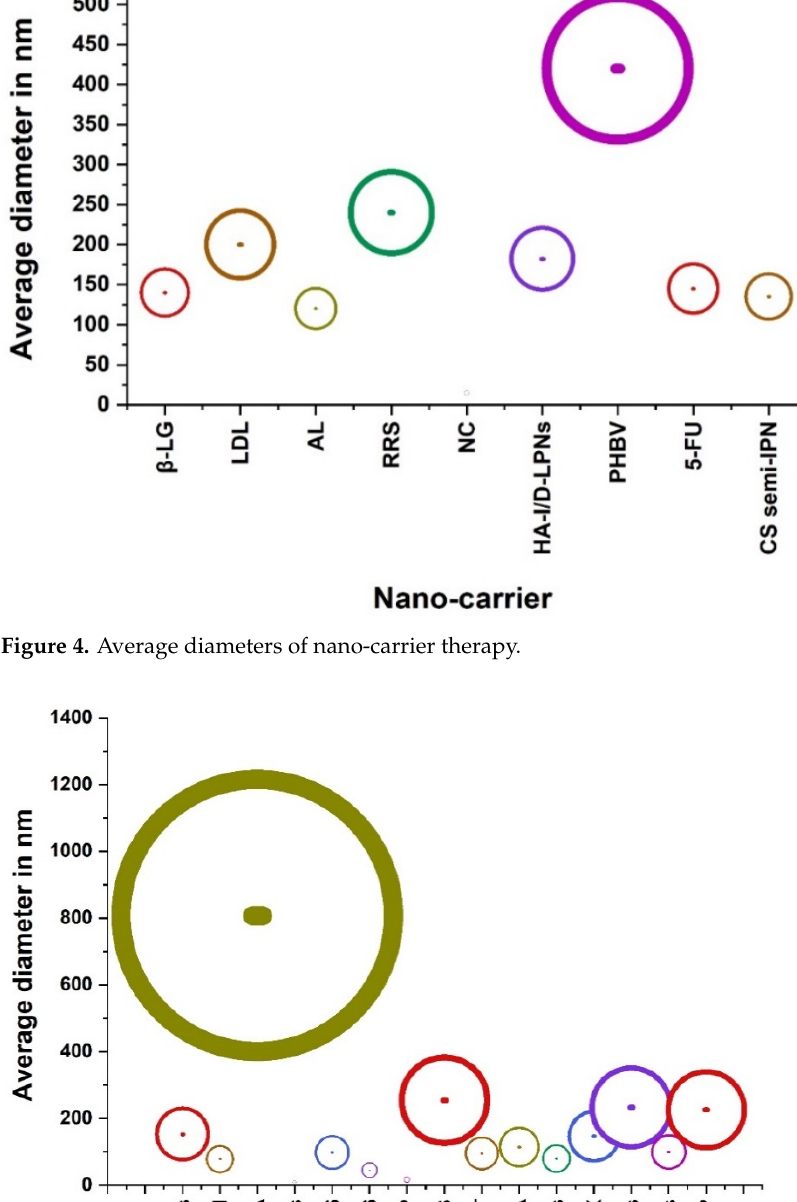
Figure 6. Average diameters of anti-cancer therapy. Solutions and Future Perspectives For example, nanoparticles (NPs) are increasingly being employed to deliver medi- cations in the treatment of colorectal cancer. These substances have been demonstrated to help treat this condition. Several hurdles must be overcome before a good cancer treat- ment system can be developed. A perfect pharmaceutical system can overcome biological barriers, detect damaged tissues, and provide an instantaneous amount of a therapeutic chemical or combination. A very successful colorectal NP-based medication delivery